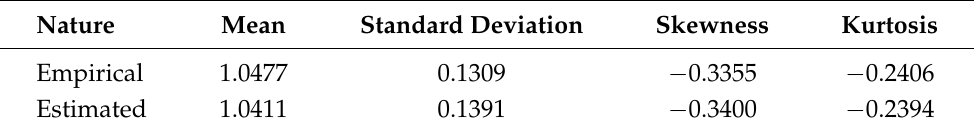
Table 9. Descriptive versus estimated statistics results for the daily precipitation